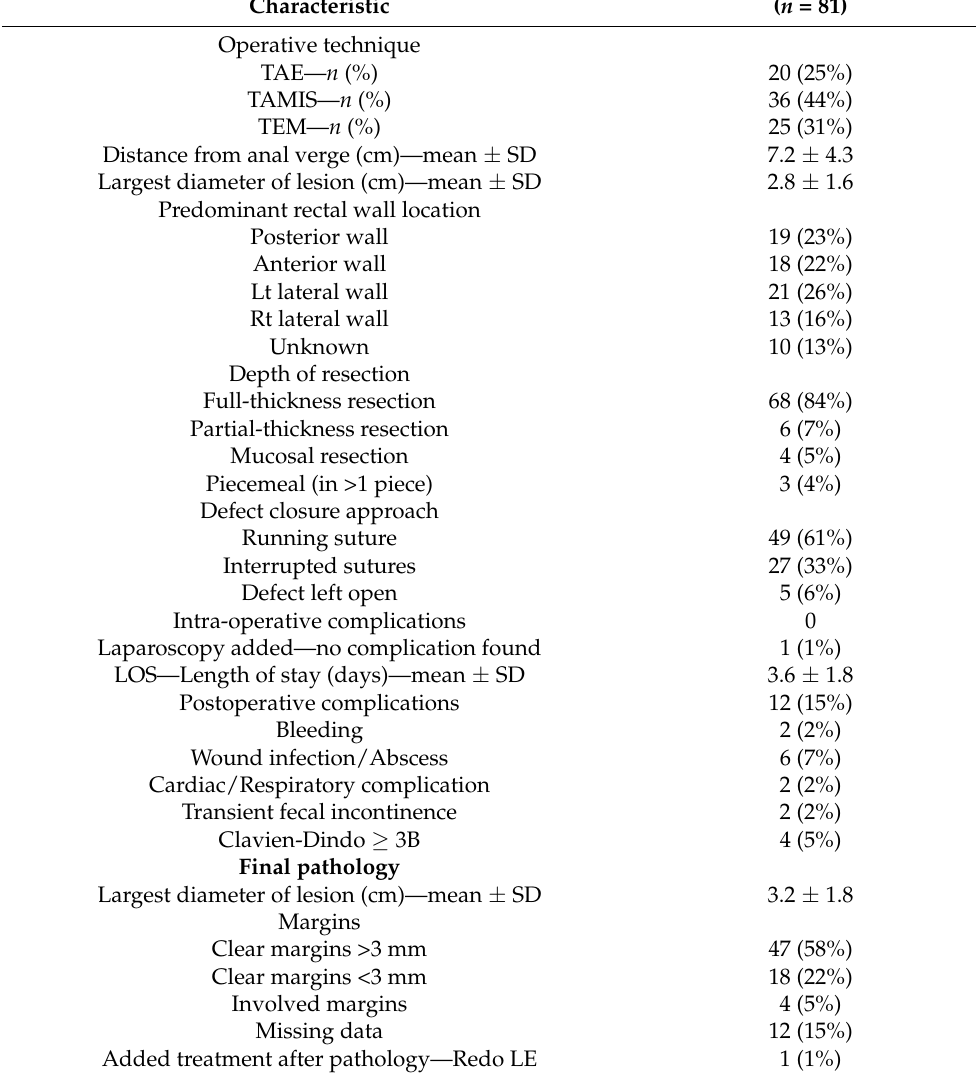
Table 2. Surgical techniques, operational findings, complications, and pathology reports.